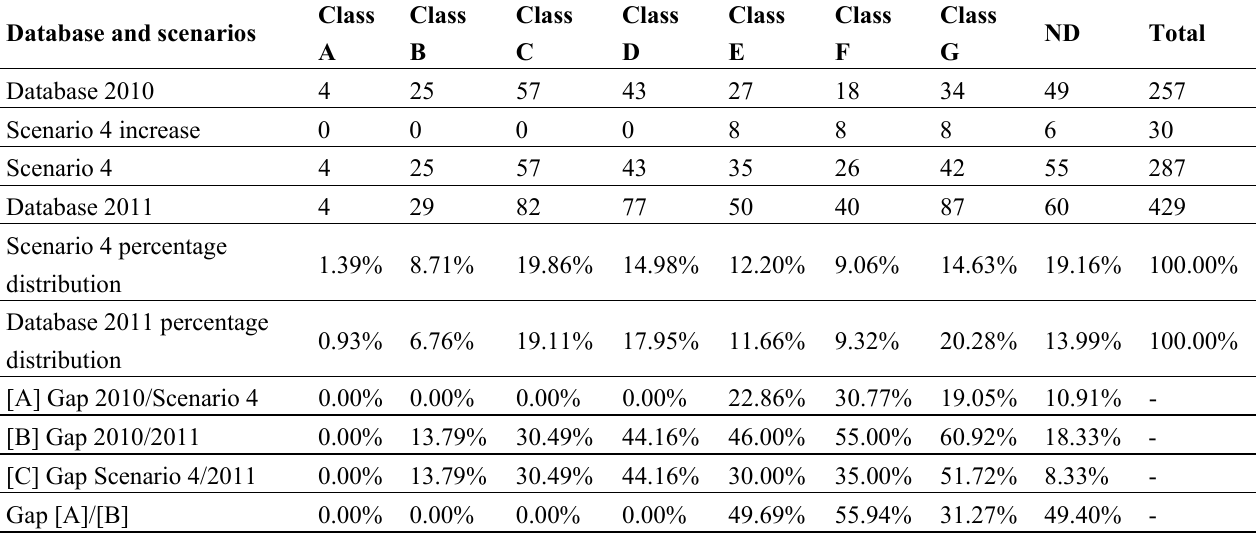
Table 14. Energy Class distribution confrontation between database 2010, Scenario 4 and database